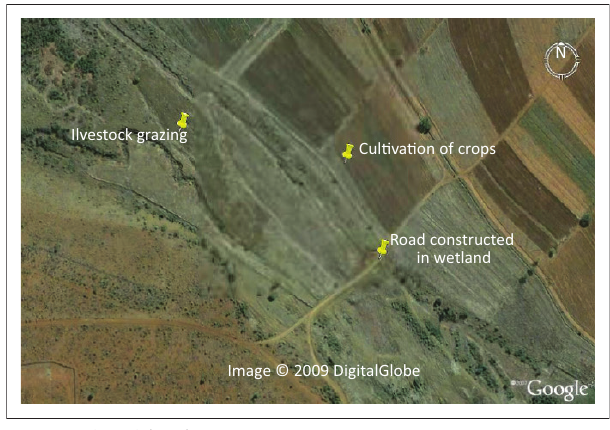
FIGURE 1: Magnified satellite image of the study area: Makhitha village, located within Makhado municipality, Vhembe district, Limpopo Province.